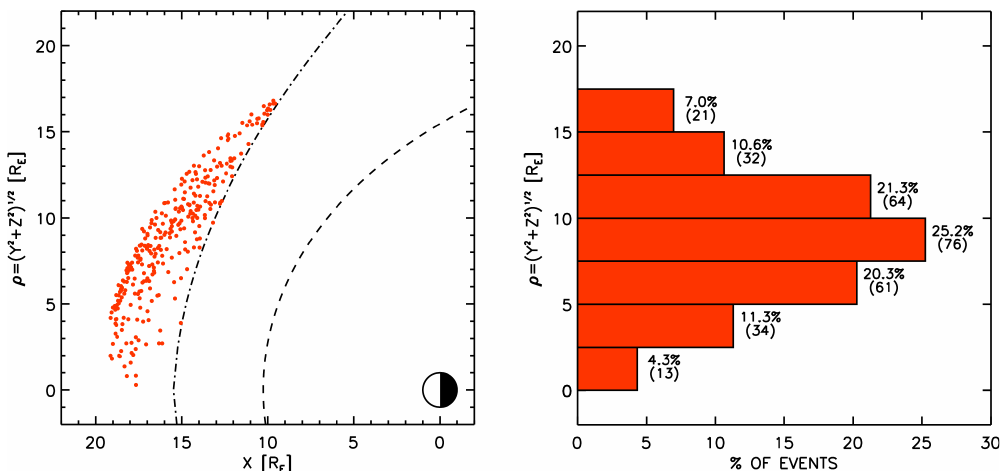
Fig. 1. The locations of the Cluster 1 spacecraft at the times of substorm onsets investigated in this study. The location of the spacecraft at the time of each onset is indicated as a dot in the left-hand panel, plotted according to its location in the GSM X direction and ρ = (Y 2 + Z 2 ) 1 / 2 , the perpendicular distance from the Earth-Sun line. Model bow shock and magnetopause locations (after Roelof and Sibeck, 1993, and Shue et al., 1997) are included for reference and indicated by dash-dotted and dashed lines respectively. The right-hand panel shows the distribution of events as a function of ρ